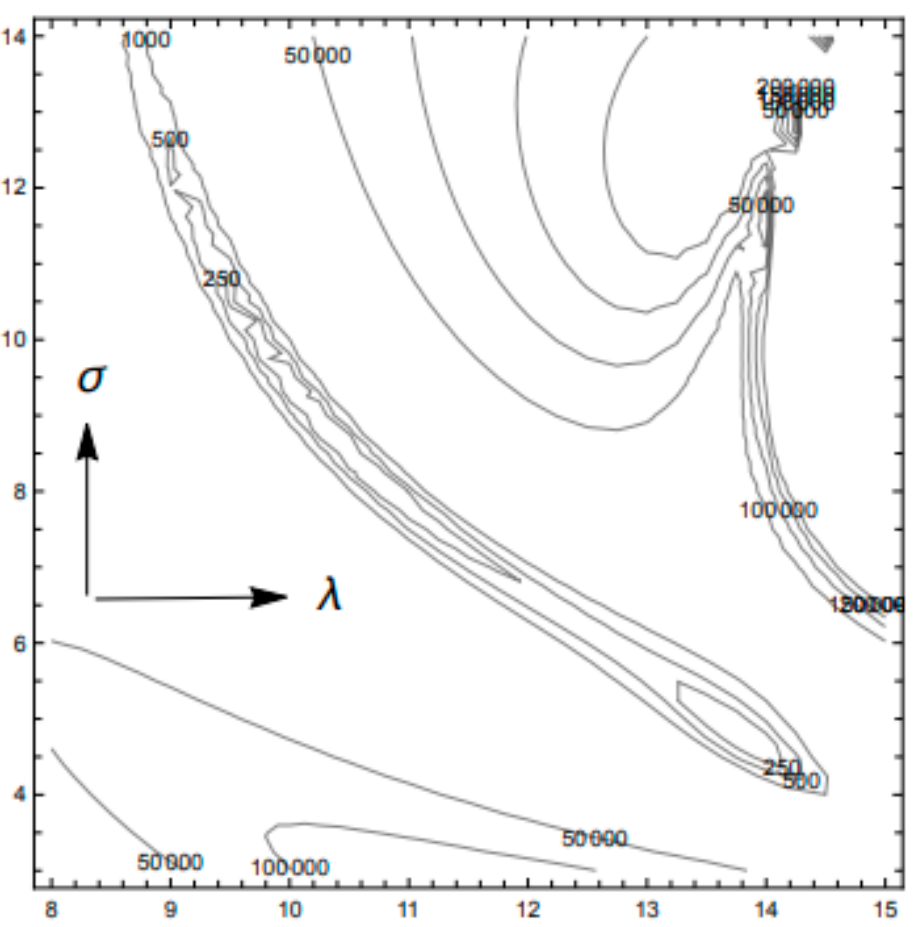
Figure 13. Plot of the cost function based on Equation (32) for the nonchaotic regime using S-LOM (3). The minimum is located at λ = 13.8, σ = 4.8 ( λ the horizontal axis and σ the vertical axis). 5.3. Experiment 3: Chaotic Data Assimilation Process (Lorenz Scaling).